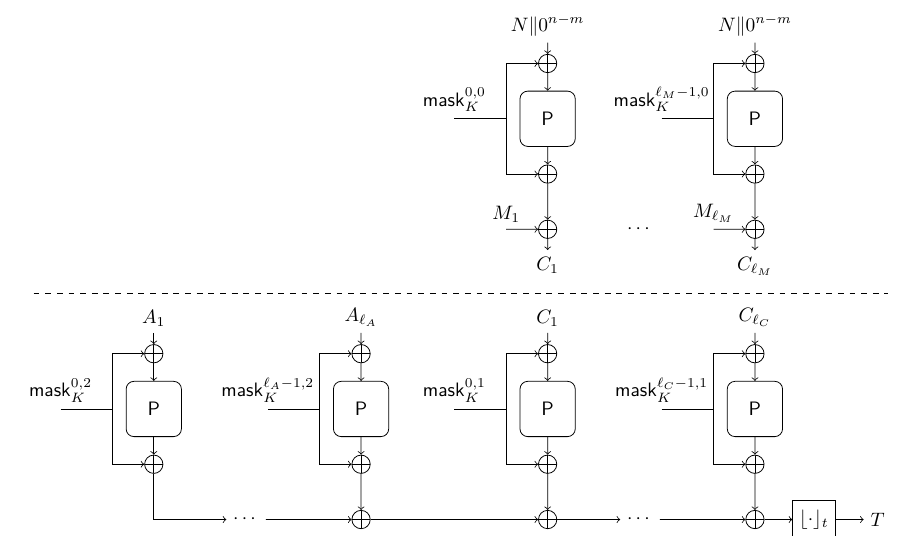
Figure 1: Depiction of Elephant . For the encryption part (top): message is padded as . For the authentication part n ←− M , and ciphertext equals C = b C M 1 . . . M ‘ 1 . . . C ‘ M c | M | M (bottom): nonce and associated data are padded as A n ←− N k A k 1, and ciphertext 1 . . . A ‘ A is padded as C n ←− C k 1 . . . C ‘ C